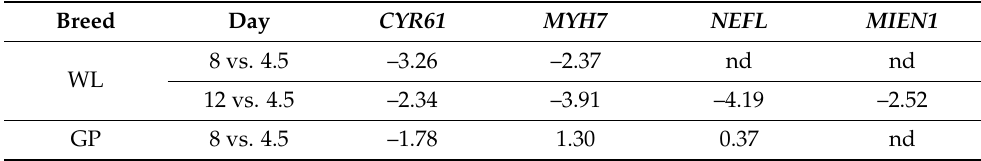
Table 2. Statistically significant gene expression changes detected on the microarray (GeneSpring software) in particular points of embryonic development of two chicken breeds—WL and GP.